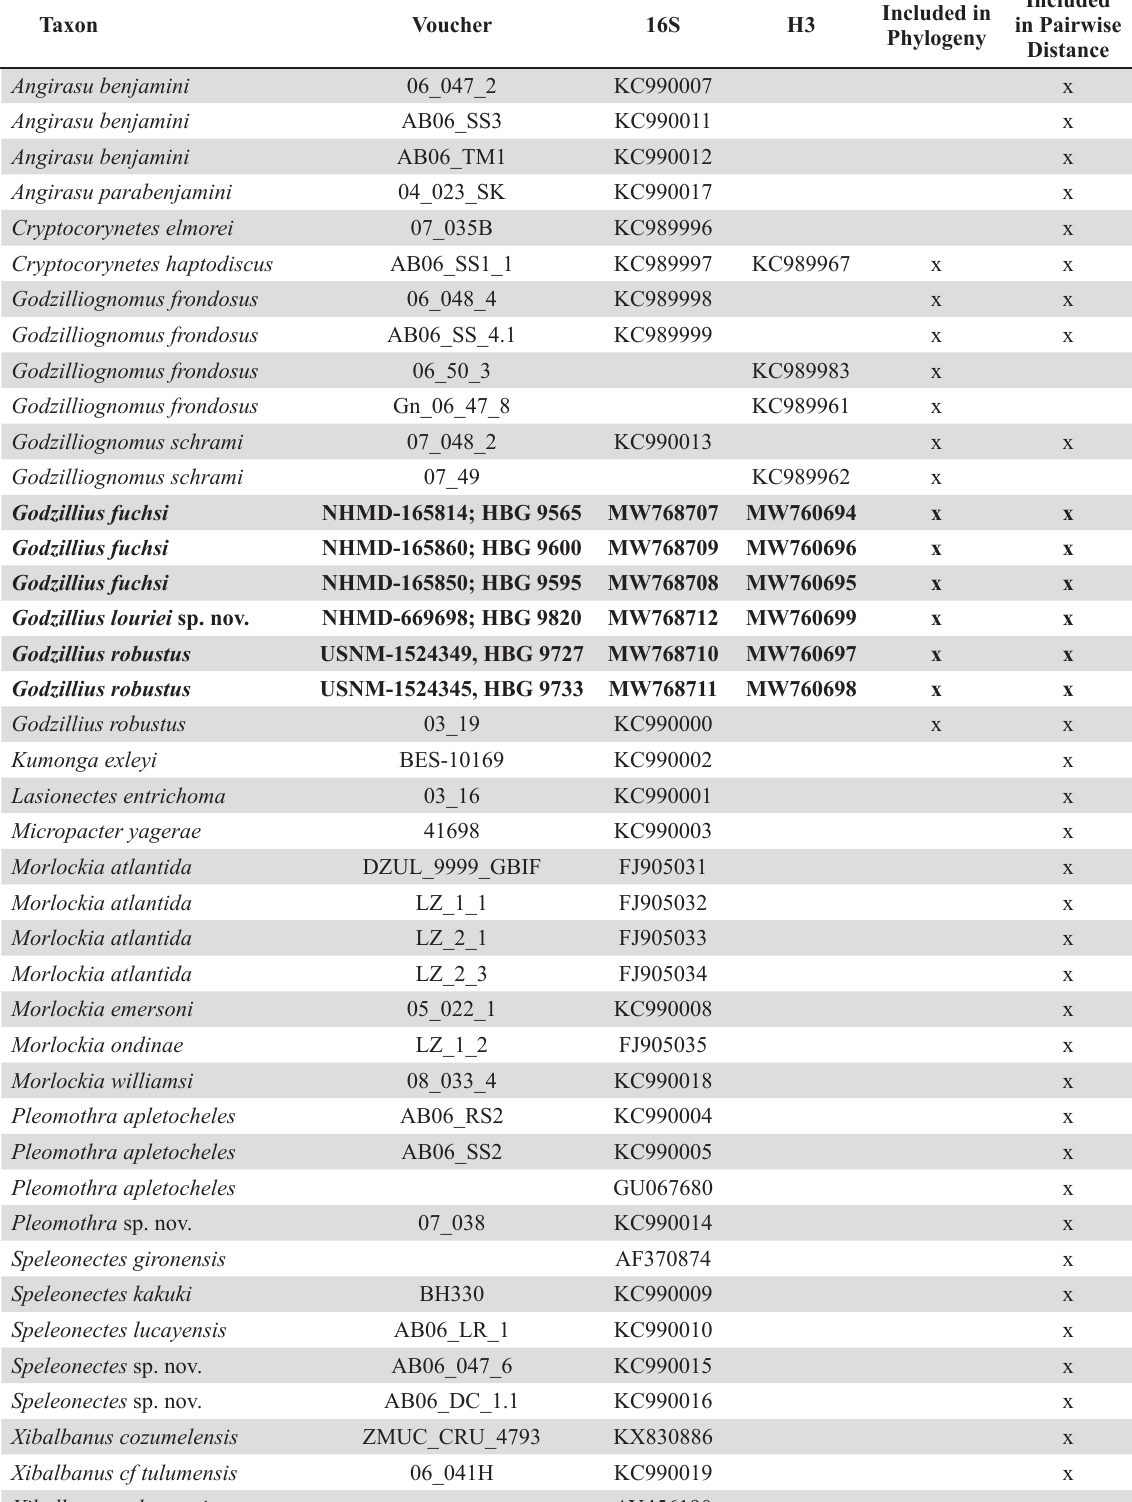
Table 1. Taxon and voucher information for all sequence data included in phylogenetic and pairwise distance analyses. GenBank accession numbers provided for each gene used; bolded individuals indicate sequence data novel to this study (HBG = Florida International University Crustacean